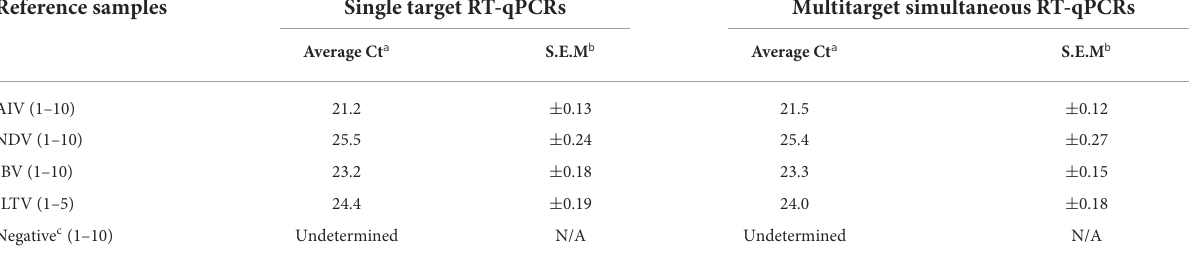
TABLE 2 Detection limit (Ct) and reproducibility of reference samples in applied multitarget simultaneous RT-qPCR assays.